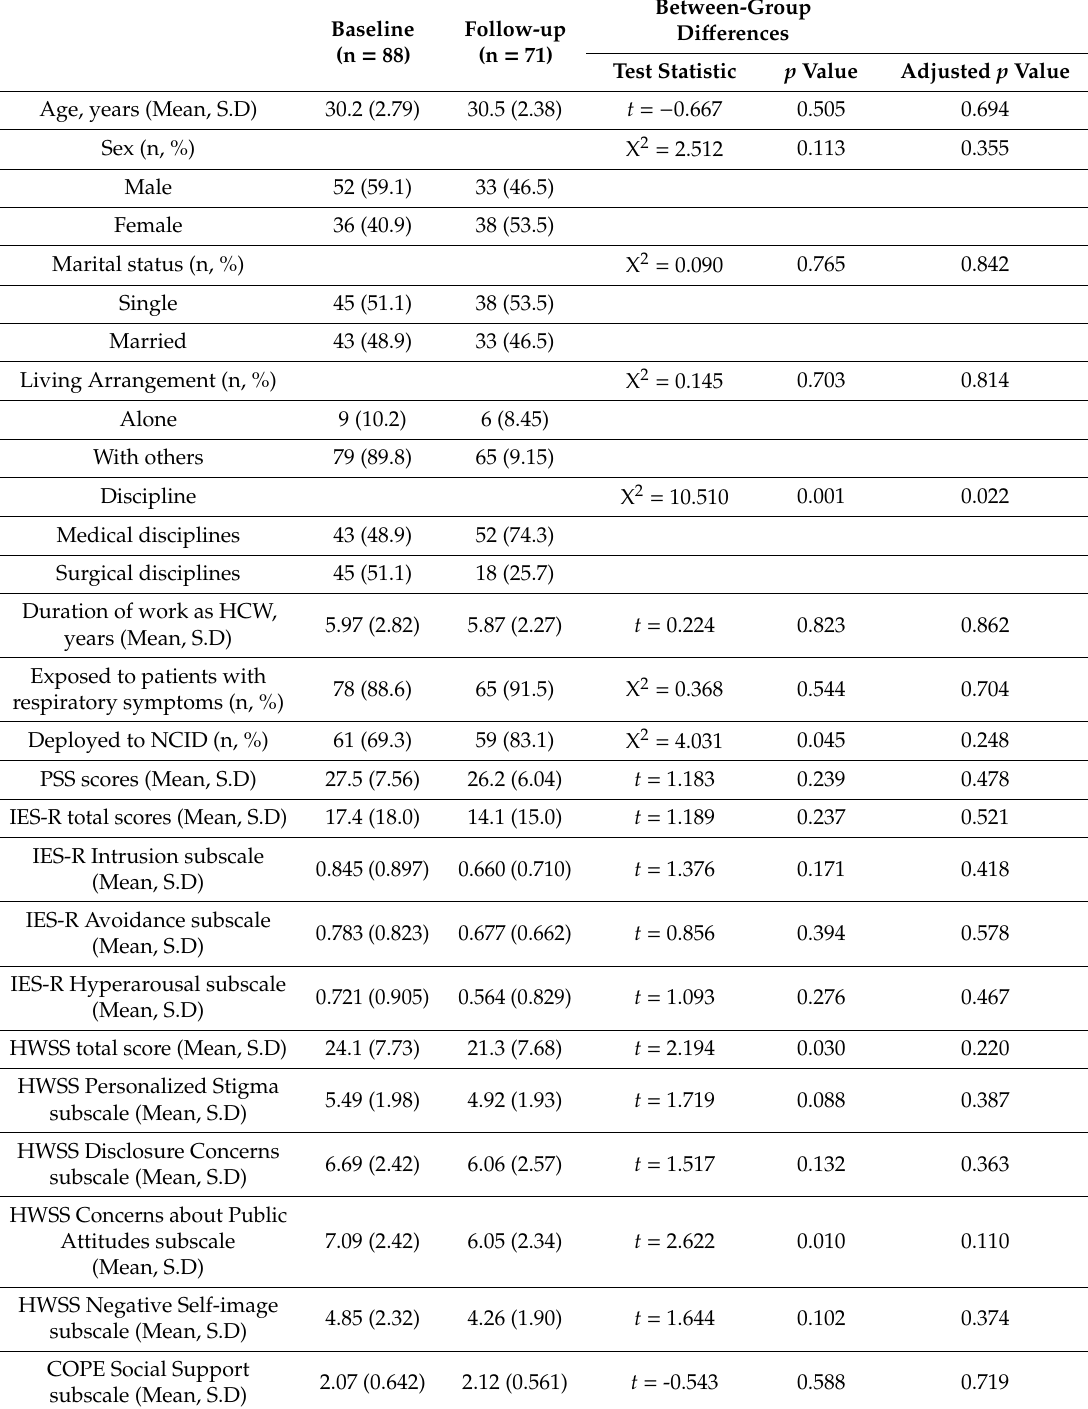
Table 2. Demographic and clinical variables of residents deployed outside usual job scope (baseline vs.